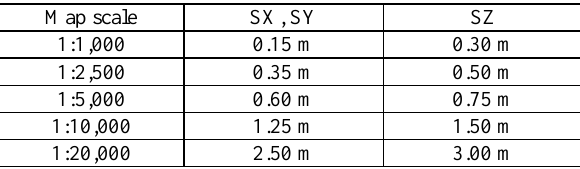
Table 1: MOMRA required standard deviations for mapping Aerial survey, line mapping and geospatial